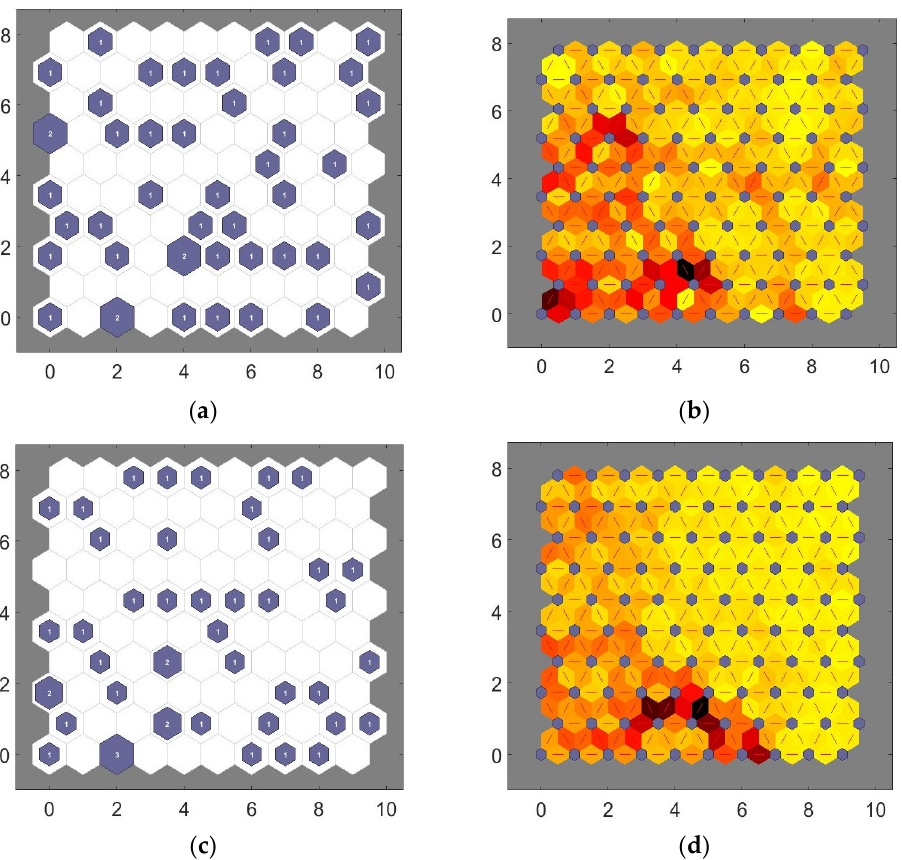
Figure 6. Plot of neighborhood distance and input vector hits of conditions 1 and 4. ( a , b ) represent- ing the AP direction, ( c , d ) representing the ML direction. The horizontal and vertical axes are neu- rons